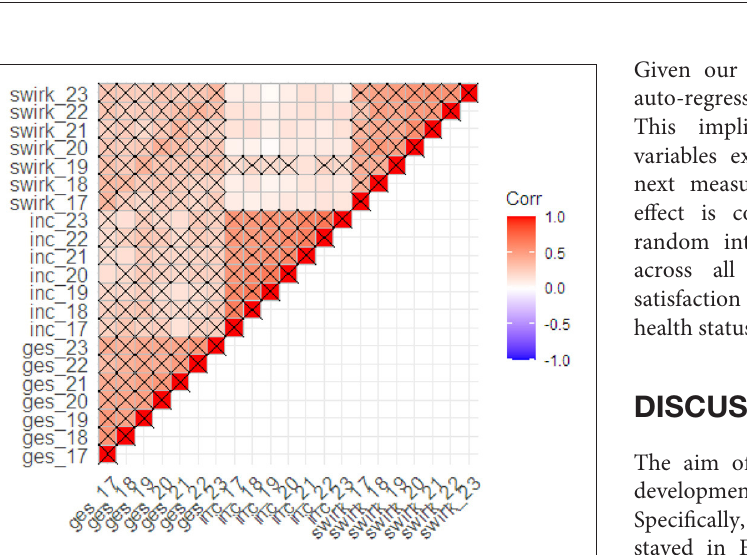
health and vice-versa. The same was not true for the slope of